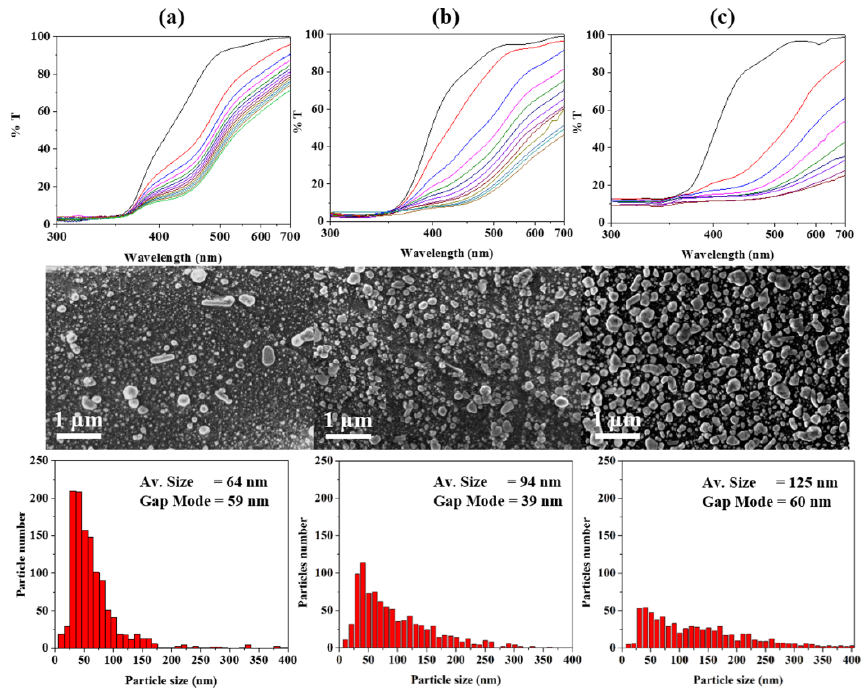
Figure 7. UV–Vis transmittance spectra showing the plasmonic dip evolution from 0 min. (black curve, water filled chip) to the final reaction time, with 1 minute step (the same colour sequence is used in all graphs, starting from the red curve, corresponding to the silver precursor injection), FESEM micrographs, and particle size distributions of the samples synthetized using a 10 mM AgNO 3 solution with a flow rate of 3 mL/min at a temperature of ( a ) 20 °C, ( b ) 40 °C, and ( c ) 60 °C.